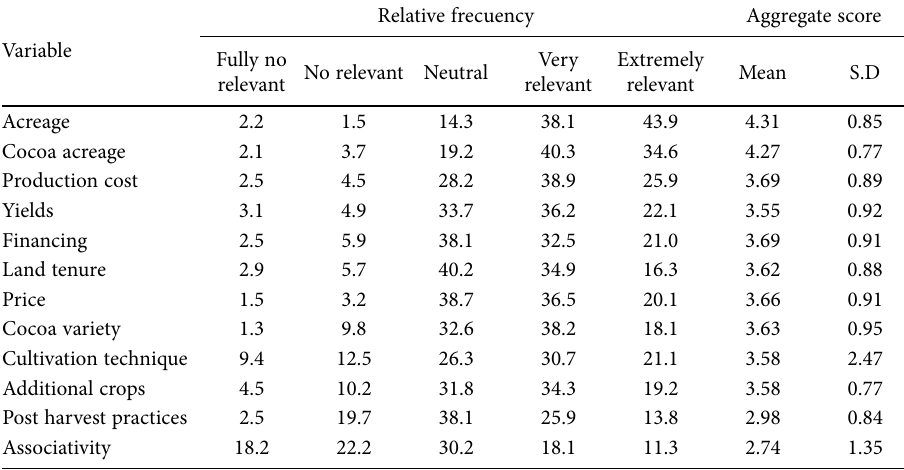
Table 5. Producers’ perception of the relative importance of productive performance aspects.